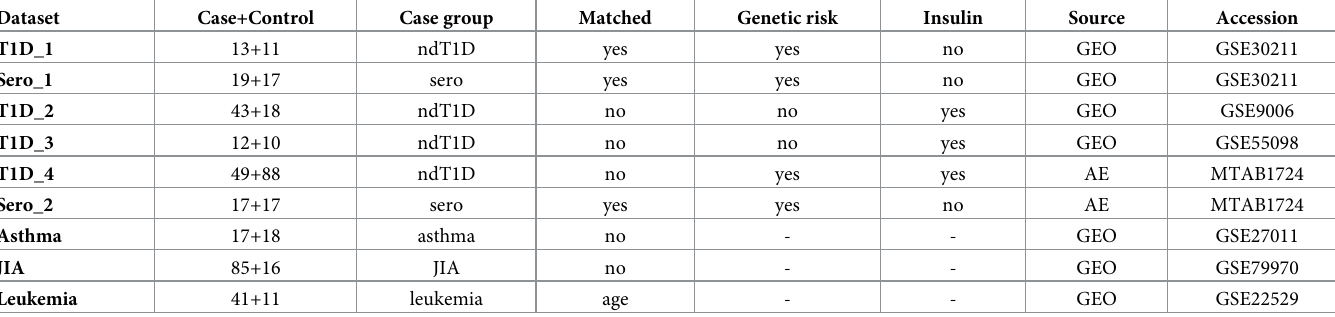
Table 1. Summary of the nine analyzed